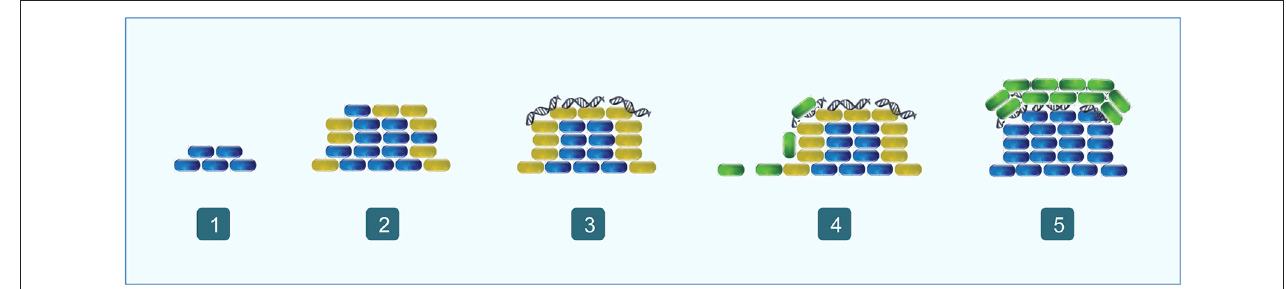
FIGURE 4 | Biofilm formation in Pseudomonas aeruginosa . (1) Non-motile cells begin to accumulate forming the stalk (blue); (2) most of the outer cells express the PQS system (orange); (3) eDNA begins to accumulate over the stalk forming ring-like shaped structures (orange fibers); (4) motile cells migrate toward the top the stalk (green); (5) motile cells form the cap